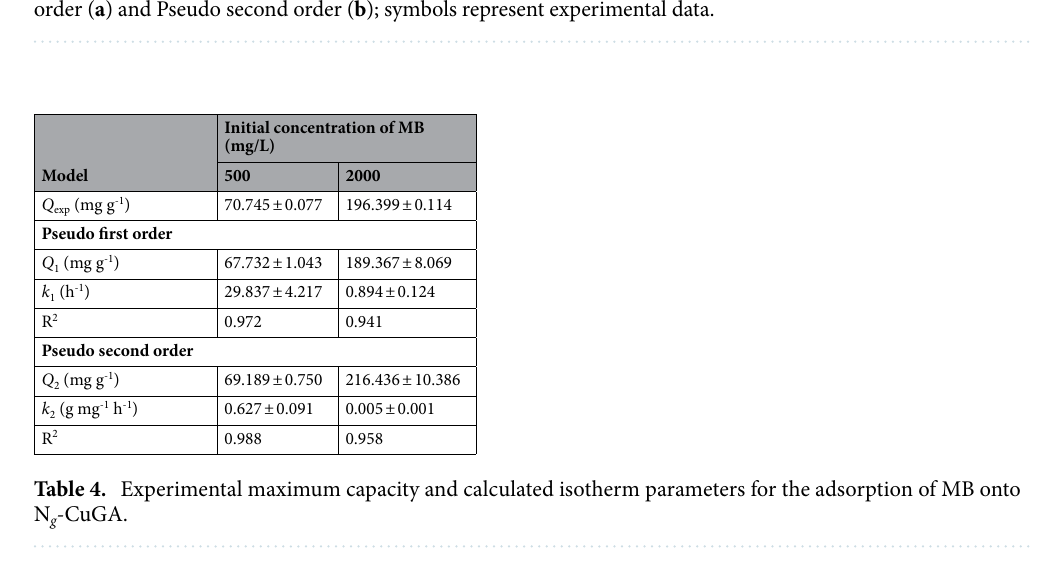
Figure 6. Adsorption kinetics of MB onto N g -CuGA. The solid lines represent data fitting to the Pseudo first order ( a ) and Pseudo second order ( b ); symbols represent experimental data.